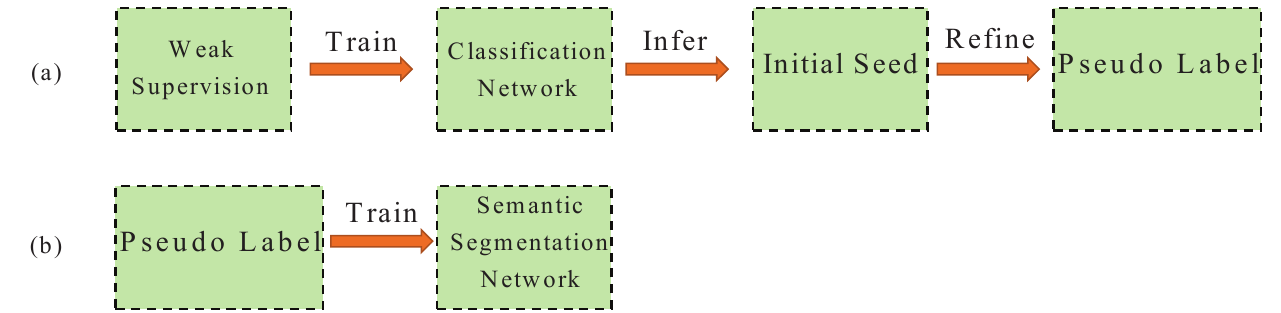
Figure 1. Weakly supervised segmentation: ( a ) Stage 1. Synthesizing pseudo-labels by weak supervi- sion; and ( b ) Stage 2. Using pseudo-labels to supervise segmentation network training.